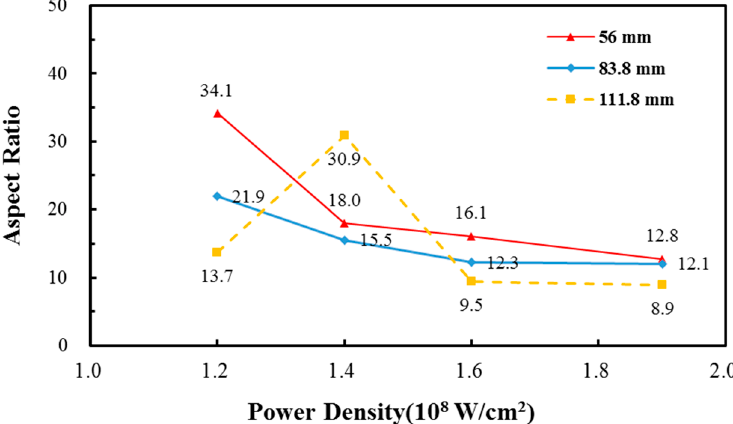
Figure 18. Aspect ratio of holes at different power density with three different focal length.